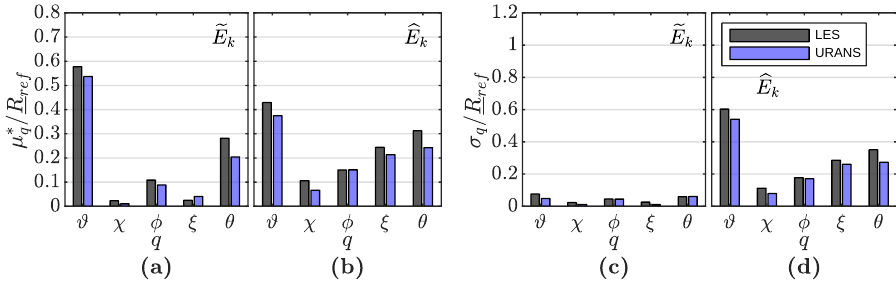
Figure 11. Normalized modified mean µ ∗ / R ref and standard deviation σ q / R ref for the responses: q ( a , c ) for the integral mean global kinetic energy (cid:101) E k and ( b , d ) for the mean absolute deviation to the reference case of the global kinetic energy (cid:98) E k